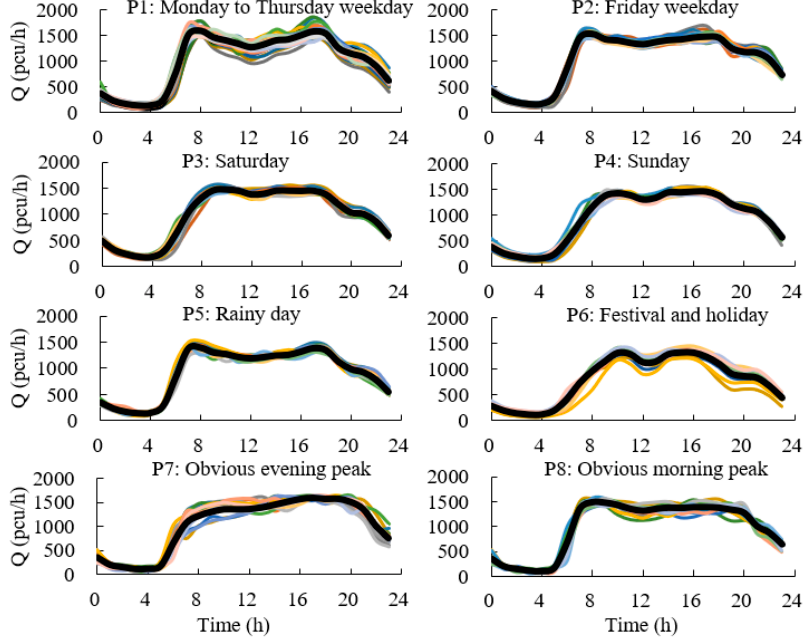
Figure 6. Clustering of expressway volume (curves with different colors mean different days).